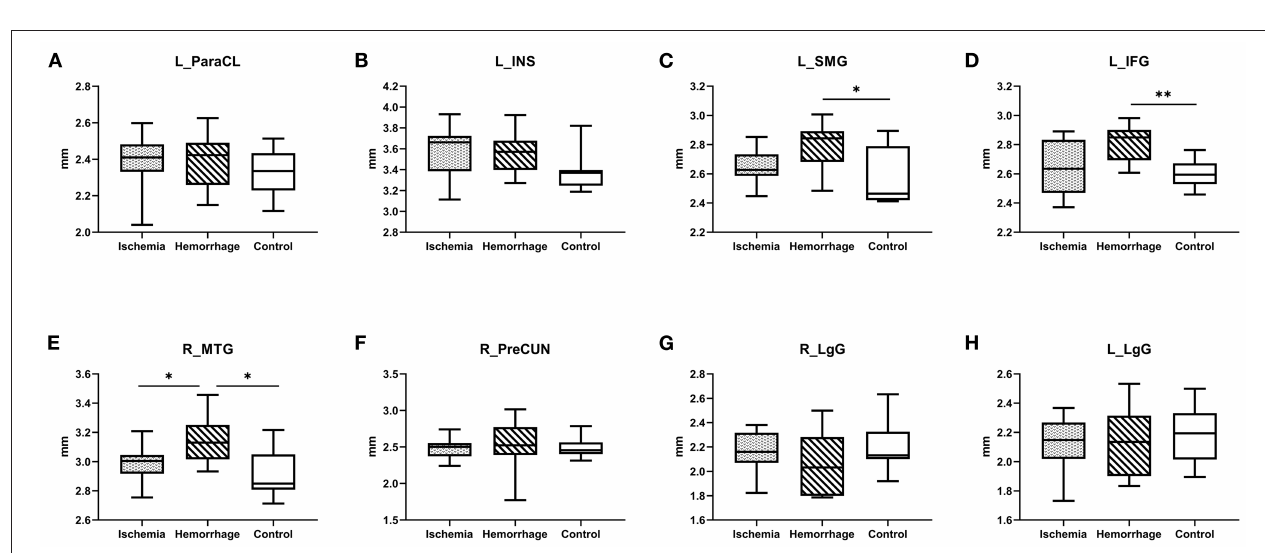
FIGURE 2 | (A–H) Comparison of cortical thickness between ischemic MMD, hemorrhagic MMD, and HCs. L means left hemisphere. R means right hemisphere. ParaCL, paracentral lobule; INS, insula; SMG, supramarginal gyrus; IFG, inferior frontal gyrus; MTG, middle temporal gyrus; PreCUN, precuneus; LgG, lingual gyrus. * p < 0.05; ** p <